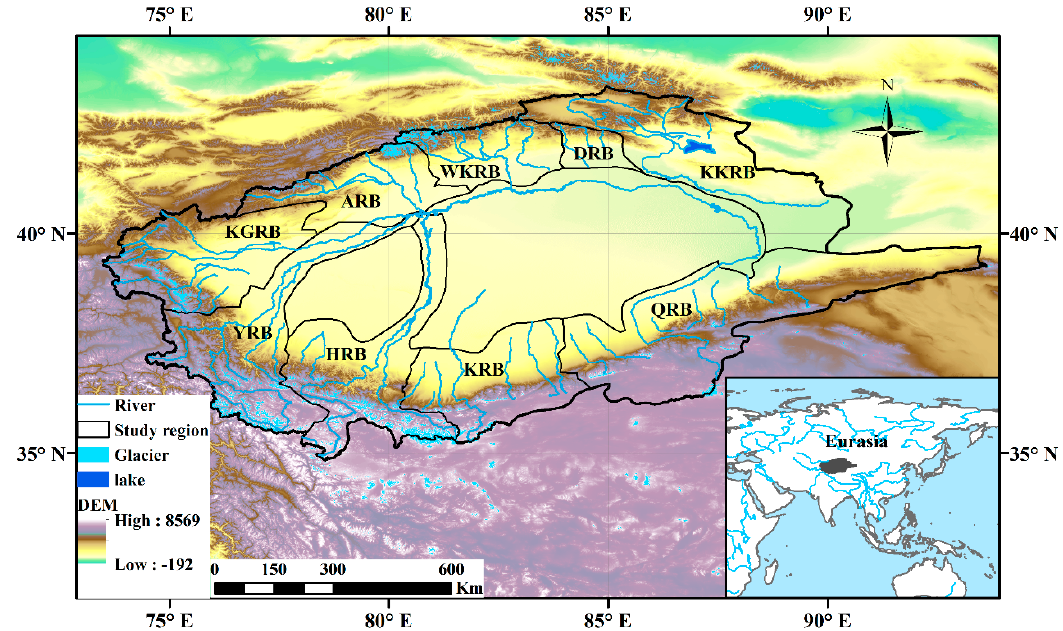
Figure 1. Location of study region on the Tarim River Basin, including the headwaters of the Yarkand (YRB), Kaxgar (KGRB), Aksu (ARB), Hotan (HRB), Weigan-Kuqa (WKRB), Dina (DRB), Keriya (KRB), Kaidu-Kongque (KKRB), and Qarqan (QRB) River Basin; and glaciers, lakes, and elevations. DEM = digital elevation model.